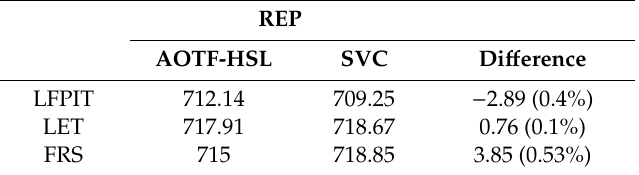
Table 10. The three di ff erent methods’ “Red edge” position results for radermachera green